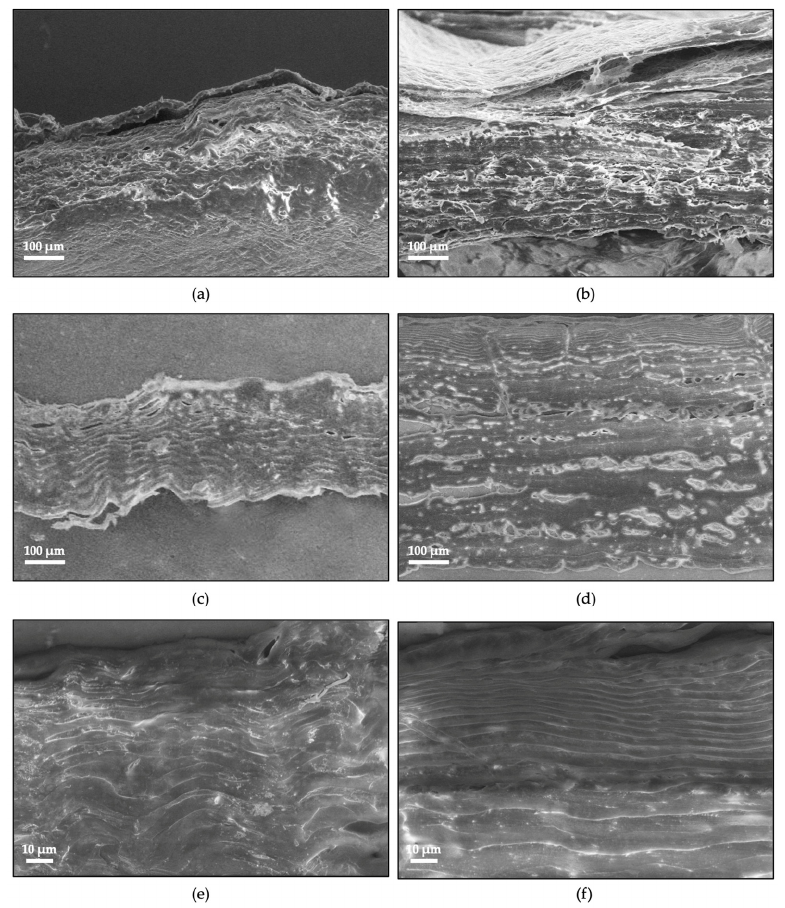
Figure 4. SEM imaging of ST ( a ) and BT ( b ) in dehydrated state, representative of the different skin thickness according to age (Magnification: 300×) and of ST ( c , e ) and BT ( d , f ) in hydrated state, showing the wavy-like structure of Tilapia skin collagen fibers (Magnification: 500× and 2000×).